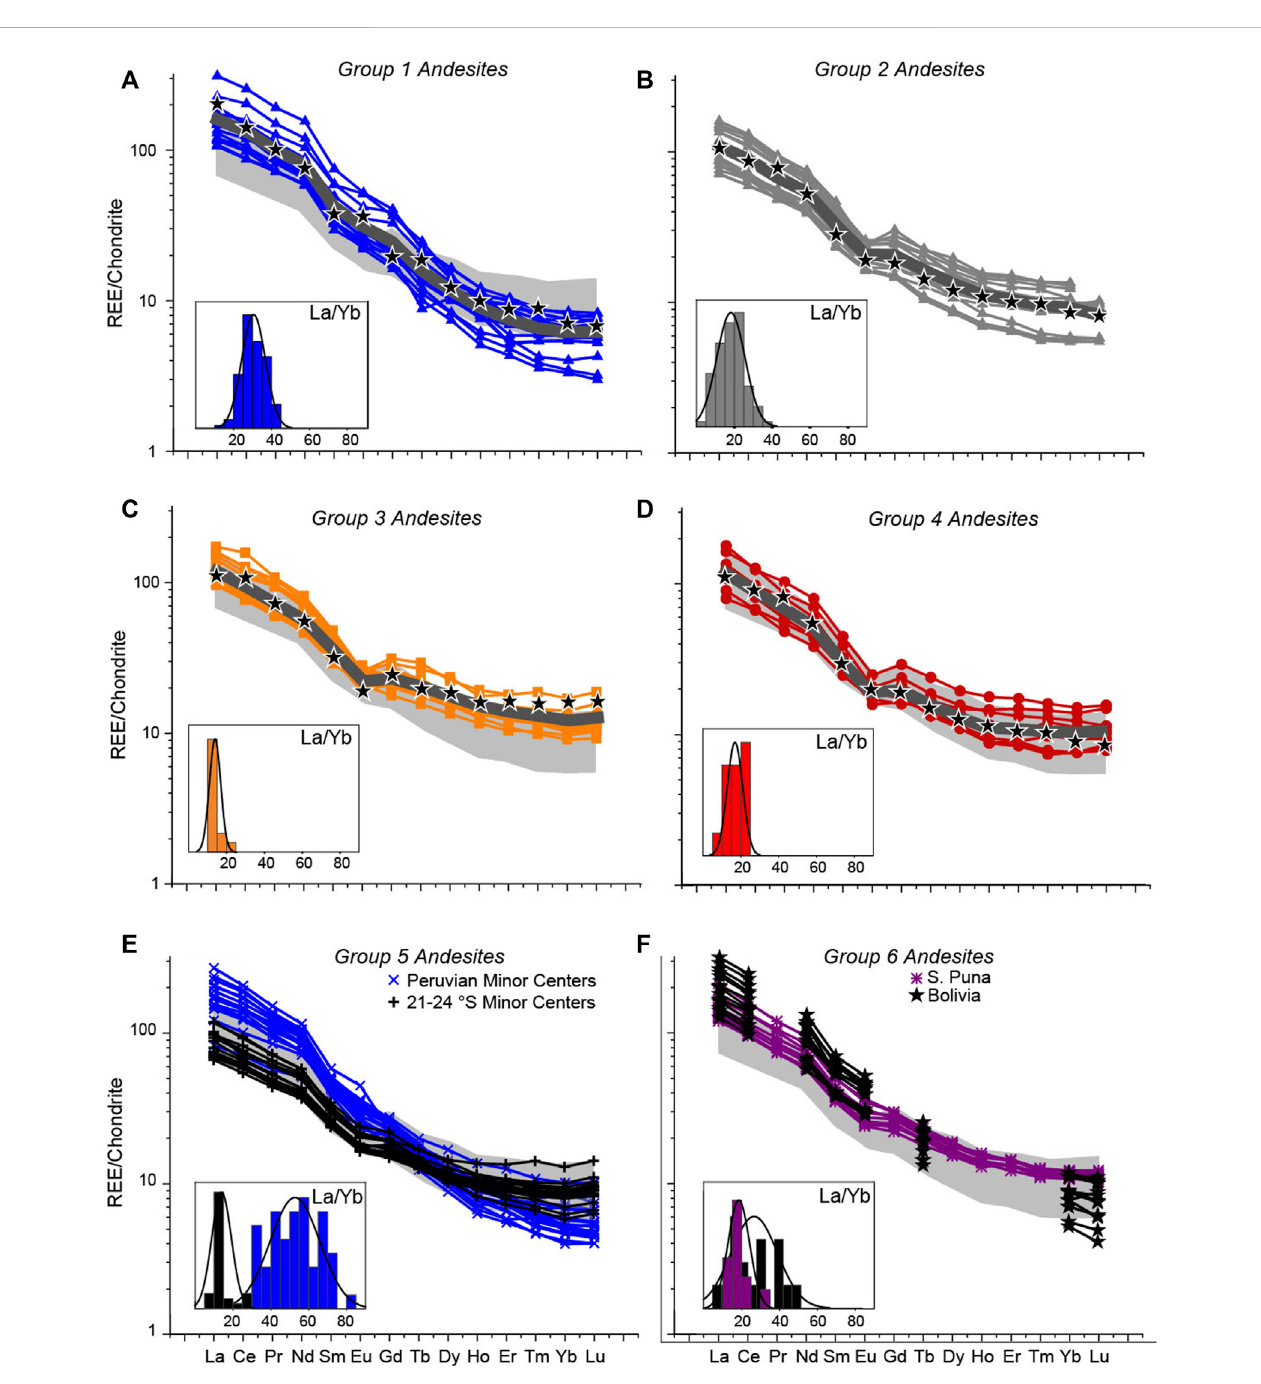
FIGURE 4 Chondrite-normalized (Sun and McDonough, 1989) REE diagrams showing compositional differences between CVZ andesites. The thick black lines represent averages, and the black stars show the crustal melting/mixing models discussed in the text and in Supplementary Appendix SA1. The inset boxes show the distribution(s) of La/Yb ratios in each group of andesite. The La/Yb histograms are overlain with normal distribution curves. Note that the group 1 andesites have considerably steeper REE patterns than other CVZ andesites. The grey fi eld on panels (A, C, D, E, and F) show the range of REE patterns from group 2 (B)